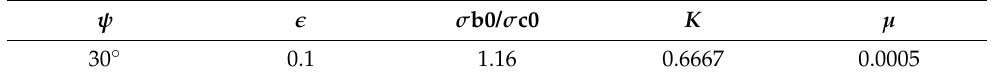
Table 3. Material properties from the coupon tests.